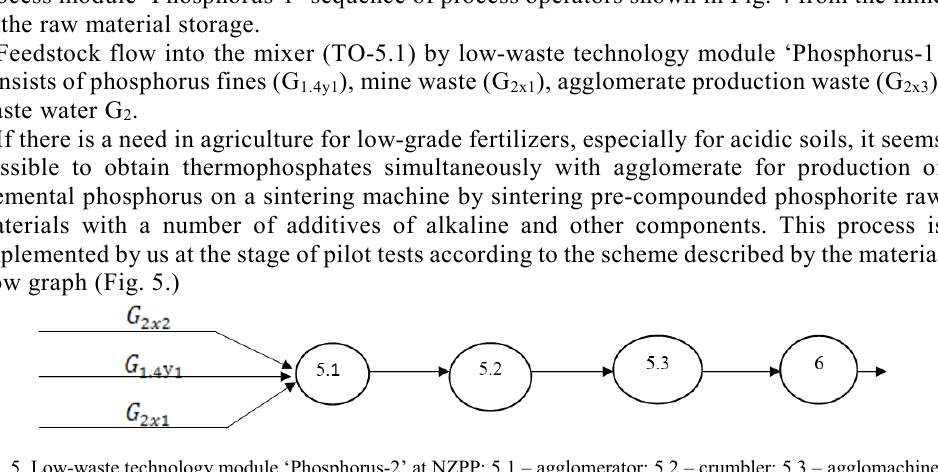
Fig. 5. Low-waste technology module ‘Phosphorus-2’ at NZPP: 5.1 – agglomerator; 5.2 – crumbler; 5.3 – agglomachine; 6 – fertilizer